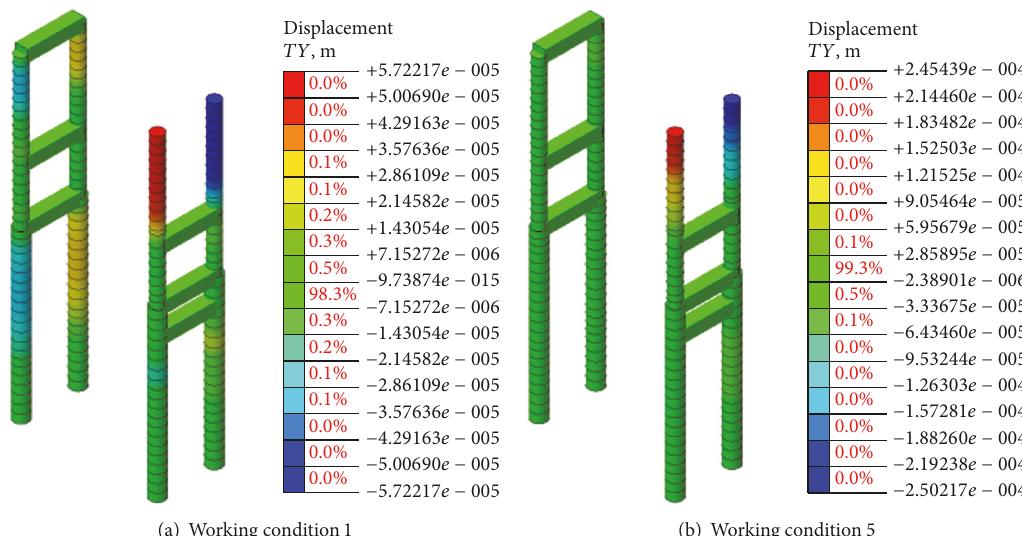
Figure 22: Longitudinal displacement of bridge